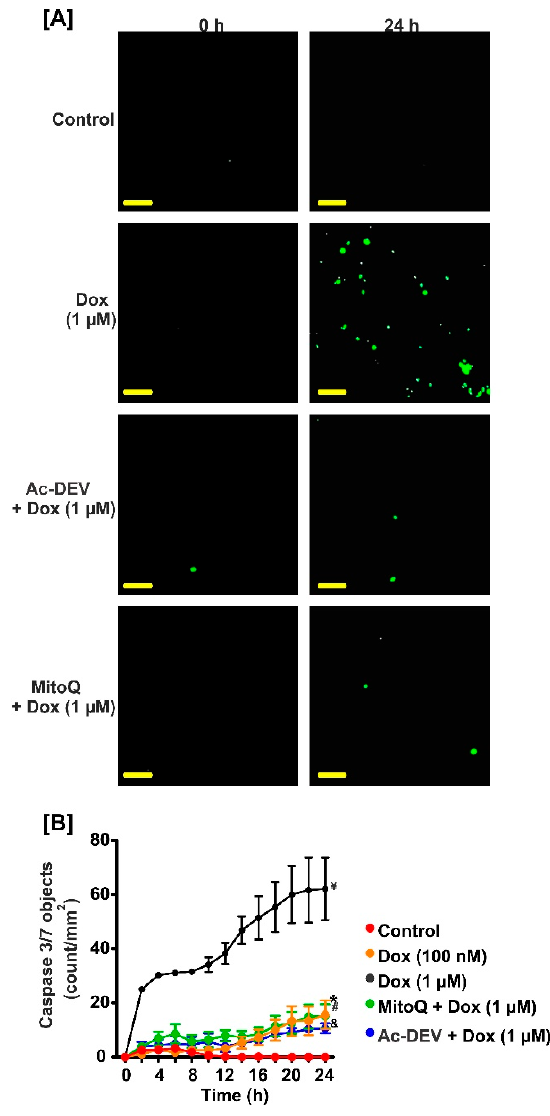
Figure 4. DOX-induced mtROS promotes caspase-3/7 activation in fetal GMCs. ( A ) Images (green fluorescence staining of the nuclear DNA in apoptotic cells) and ( B ) caspase 3/7 object count demon-strating that DOX induces apoptosis in fetal GMCs and reversal by MitoQ (1 µM) and Ac-DEVD-CHO (50 µM; a caspase-3 and caspase-7 inhibitor). ¥ p < 0.05 vs. control (2–24 h); * p < 0.05 vs. control (24 h) &,# p < 0.05 vs. DOX (1 µM; 2–24 h) (two-way ANOVA, with Tukey’s post hoc test); n = 5 each. Scale bar = 100 µM.